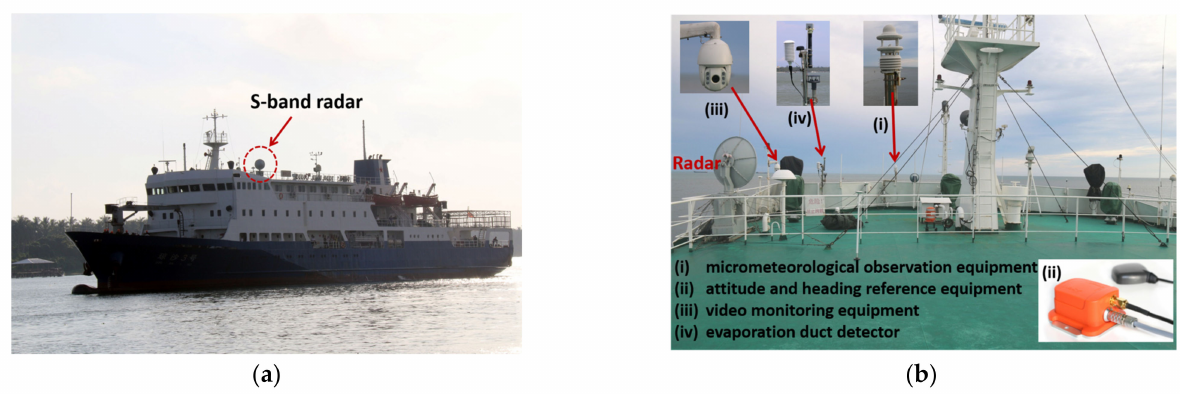
Figure 3. Scene of the over − the − horizon propagation experiment. ( a ) “Qiongsha 3” ship and S − band radar; ( b ) equipment installed on